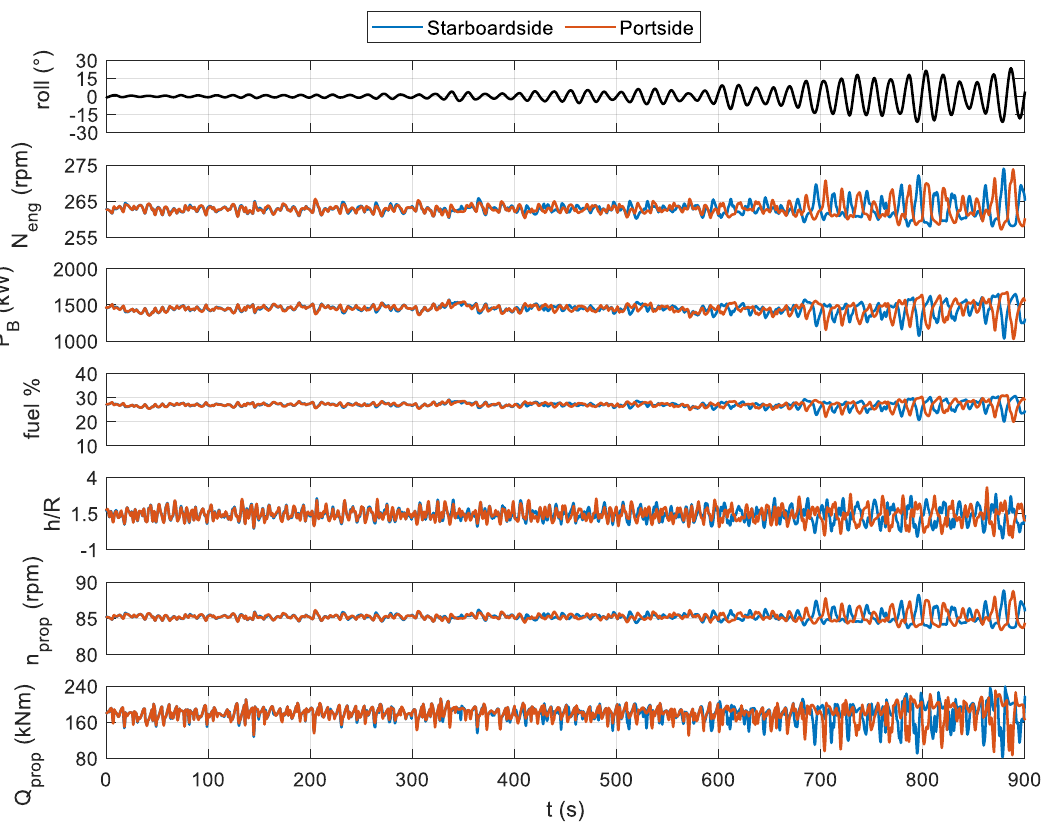
Figure 7. Time history of starboard-side and port-side propellers and engine in a head sea, Hs = 4.5 m Tz = 9.0 s, depending on ship roll motion (black line).